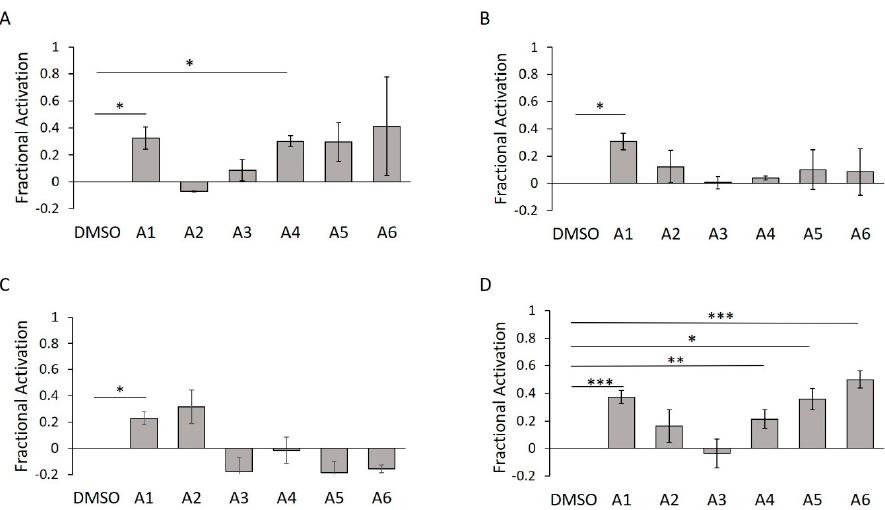
Figure 9. WT HYPE activator validation using in-gel fluorescence. ( A ) Quantification of Δ 102 WT HYPE in-gel fluorescence autoAMPylation reaction in minimal buffer without detergent. ( B ) As in ( A ), but with 0.1% Triton X-100. ( C ) As in ( A ), but with Δ 45 WT HYPE. ( D ) As in ( A ), but with Δ 45 WT HYPE and 0.1% Triton X-100. Quantified data represented as the mean +/ − SEM of three independent experiments. Unpaired t -tests were performed: * = p < 0.05; ** = p < 0.01; *** = p < 0.001.